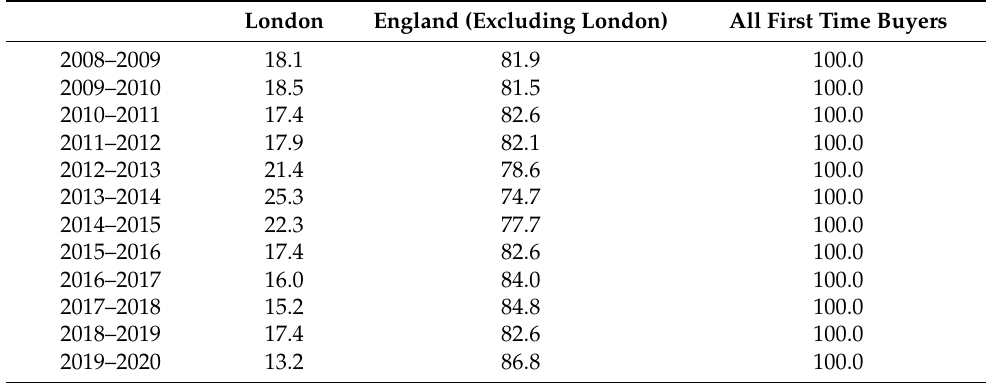
Table A5. Recent first-time buyers, London and outside London, 2003–2004 to 2019–2020 (percentages).